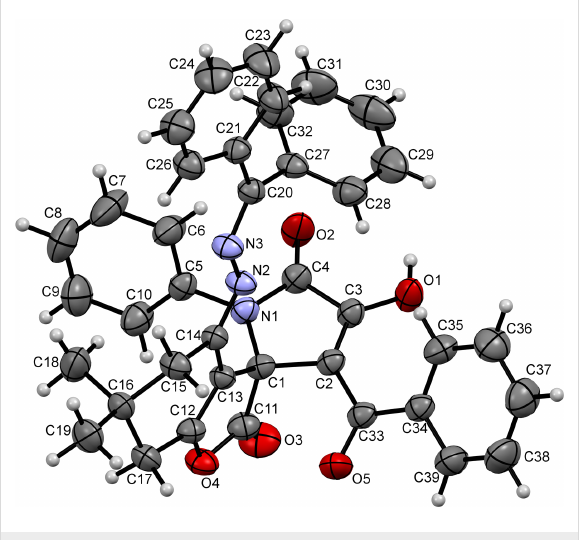
Figure 4: ORTEP drawing of compound 23aa (CCDC 1546064) showing 50% probability amplitude displacement